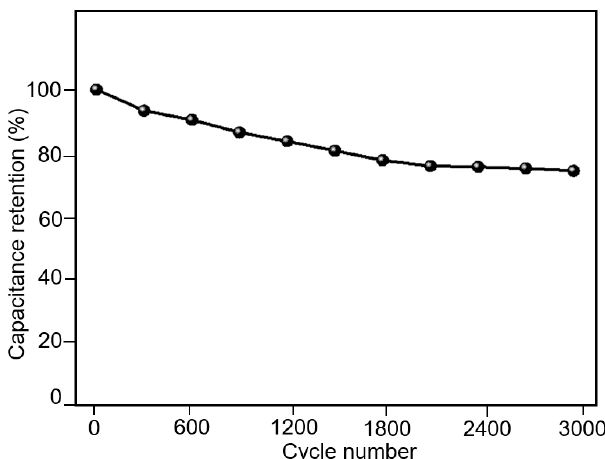
Figure 6. The electrochemical performance of the as-fabricated MoS 2 -PVDF composite electrodes. ( a ) The CV performance measured in the potential widow between − 0.2 V and 0.8 V. ( b ) The GCD curve measured with the current density of 0.5, 1, 1.5, and 2 mA/cm 2 , respectively.